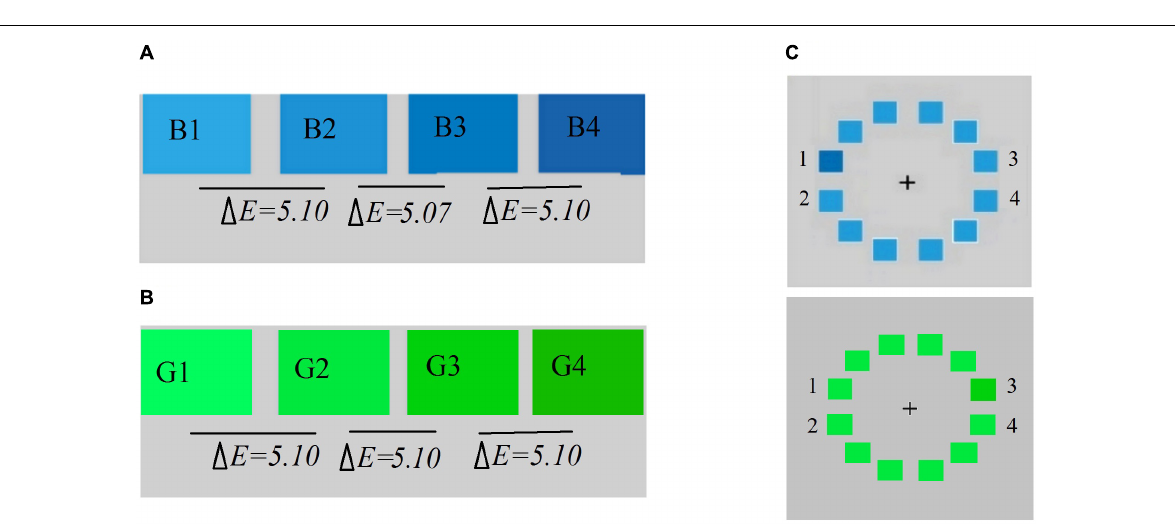
FIGURE 2 | (A) Visual search of the blue colors used; B1-B2 and B3-B4 are within-categories, while B2-B3 are between-categories. (B) Visual search of the green colors used; G1-G2 and G3-G4 are within-categories, while G2-G3 are between-categories. (C) Sample display for the visual search task in which the target occupied any of the four positions (position 1, 2, 3, or 4). Delta E refers to the color difference between the corresponding color stimuli in the CIElab